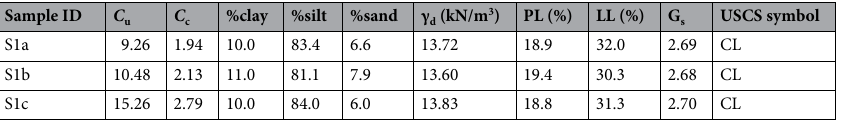
Table 1. Physical properties of Quaternary loess. C u , coefficient of uniformity; C c , coefficient of gradation; %clay, clay content; %silt, silt content; %sand, sand content; γ d , unit weight; PL, plastic limit; LL, liquid limit; G s , specific gravity; USCS, Unified soil classification